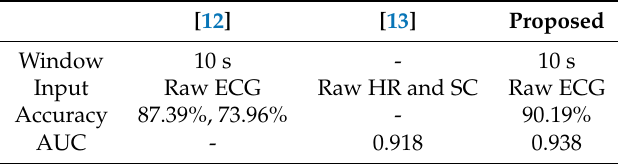
Table 7. Comparison with models featuring a DNN